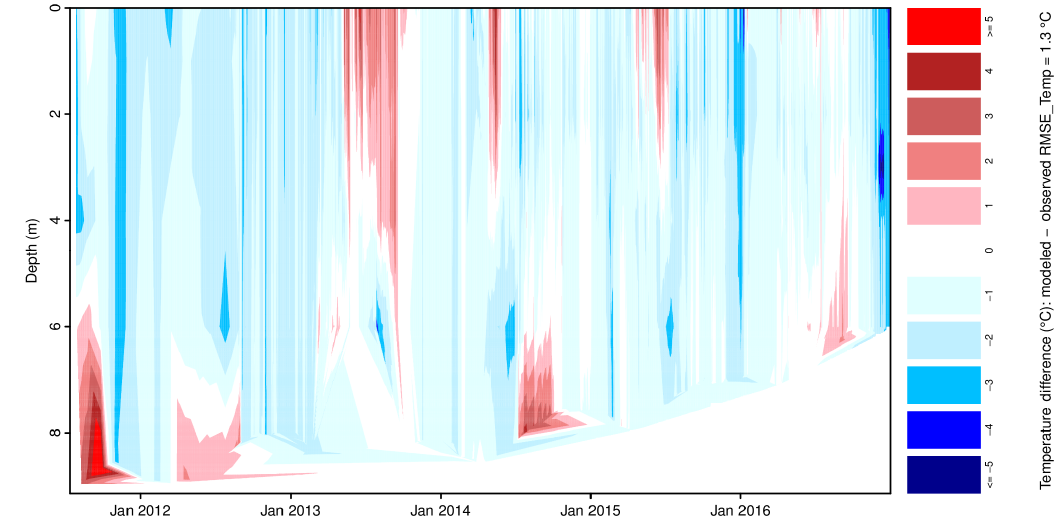
Figure B1. Contour plot of differences between simulated and observed water temperatures of lake